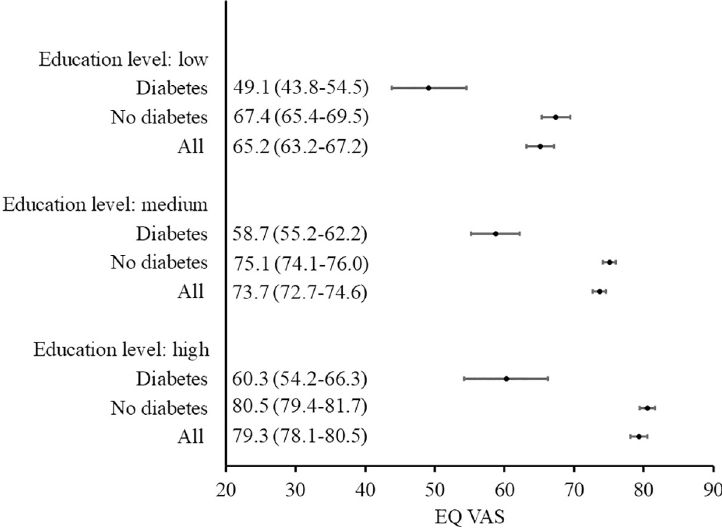
Fig 4. EQ VAS (mean, 95% confidence interval) according to education level: Comparison of respondents with diabetes versus no diabetes and the general population.